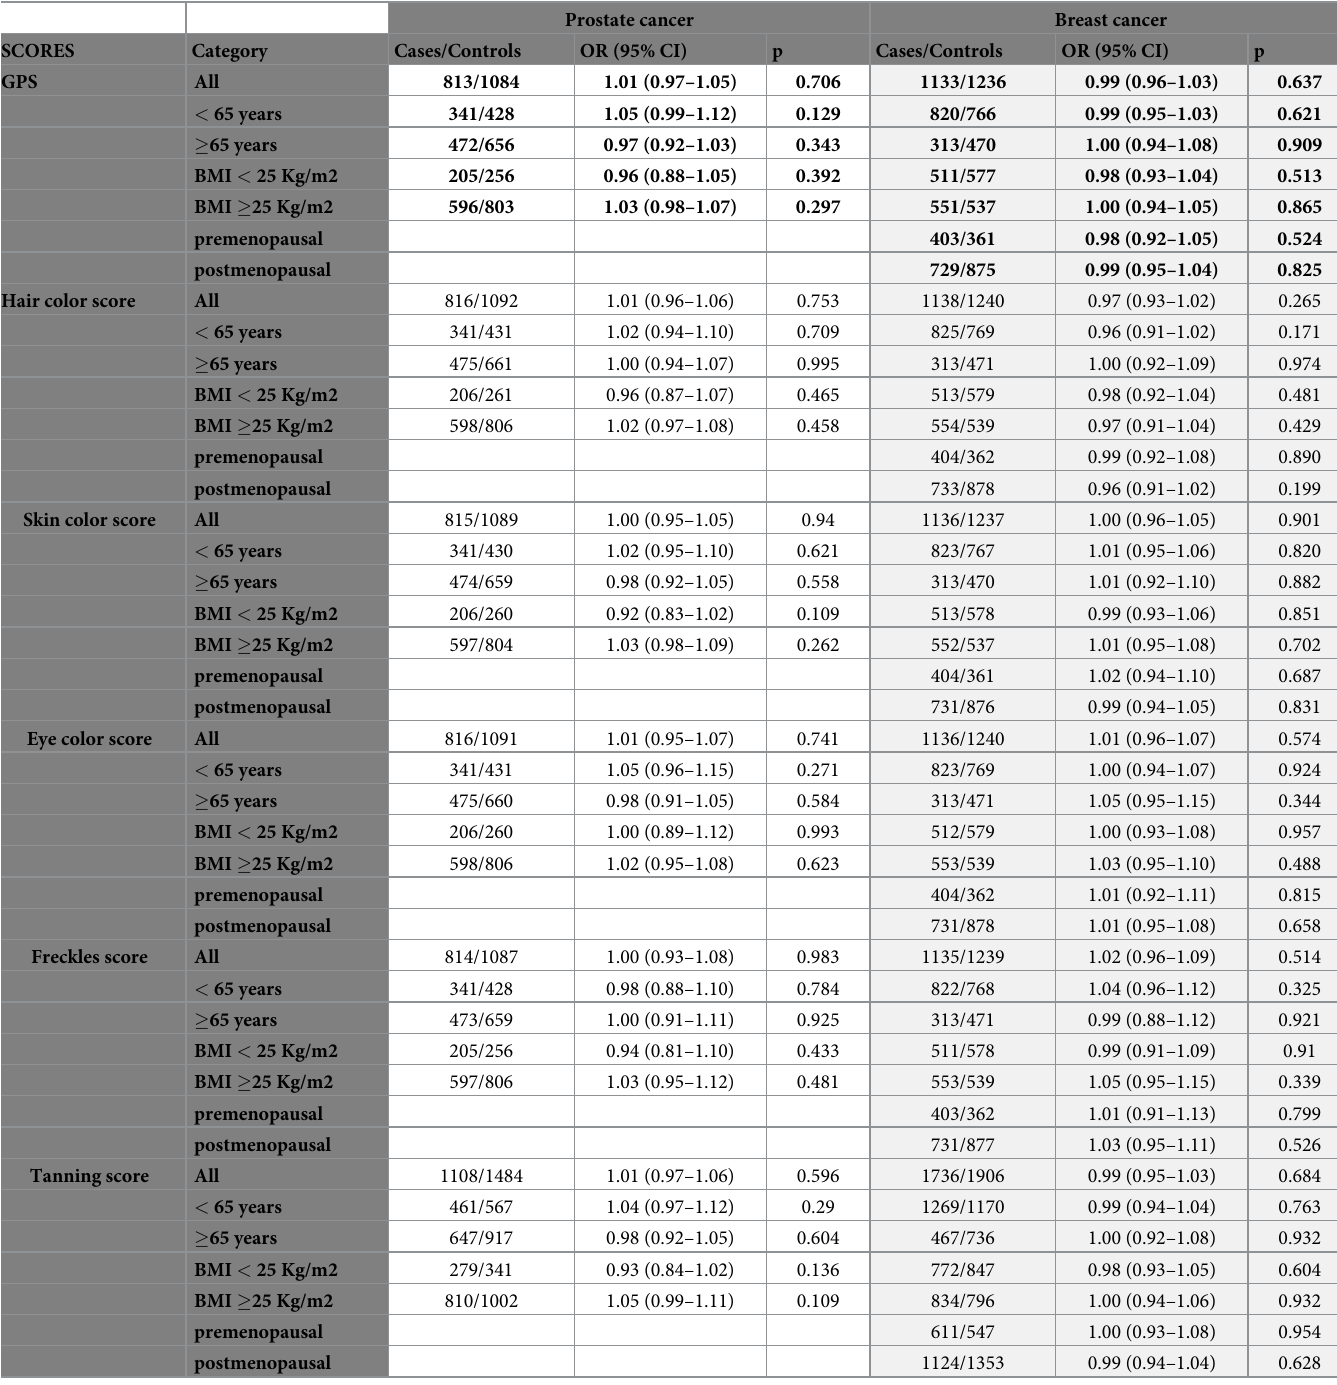
Table 3. Association between genetic pigmentation scores of phototype and prostate and breast